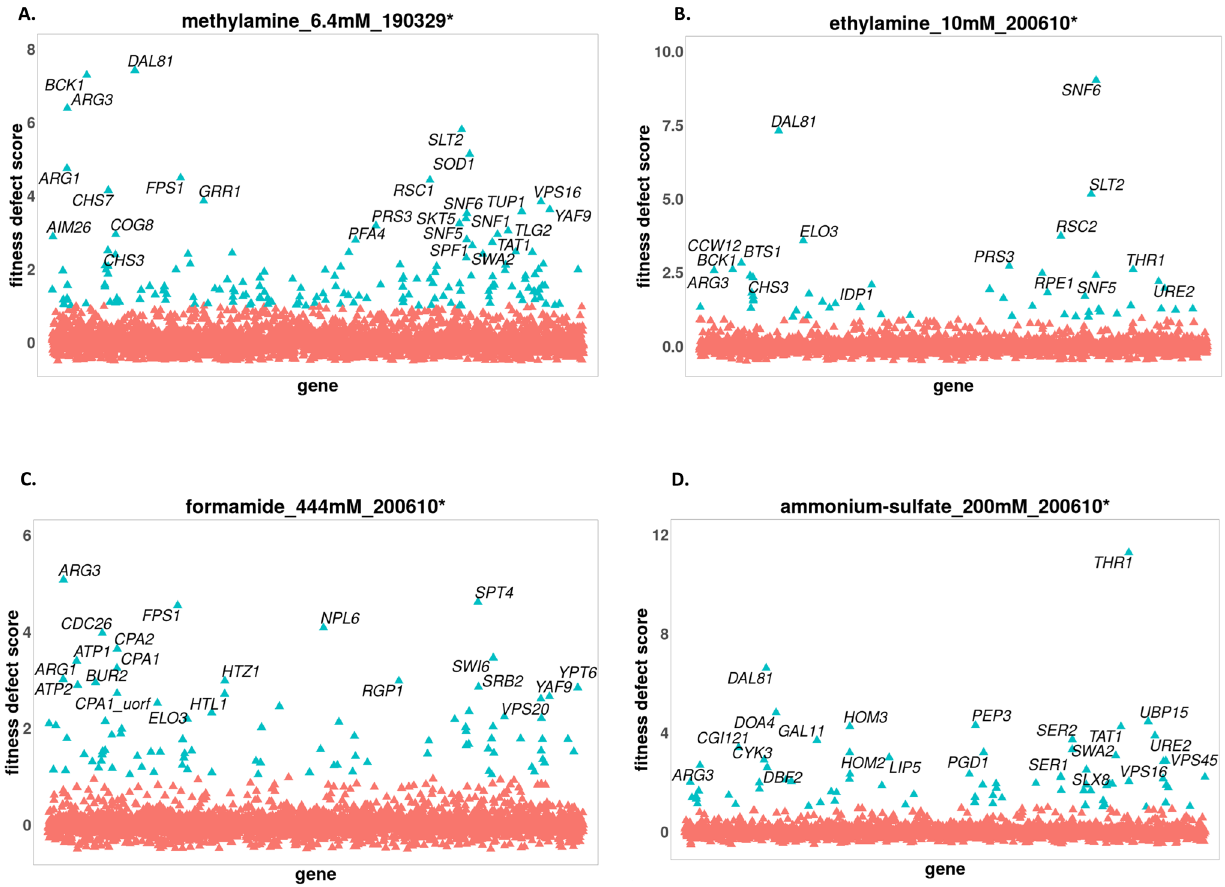
Figure 6. Fitness profile showing genes whose deletion strains are sensitive to treatment by metabolic intermediates of nitrosamines. Fitness defect scores are plotted on the vertical axis vs genes on the horizontal axis. Strains affected by the compounds lack the following genes; methylamine: BCK1 , DAL81 , ARG3 , FPS1 and GRR1 . Ethylamine: DAL81 , ARG3 , SNF6 , ELO3 , SNF6 and ELO3 . Formamide: ARG3 , FPS1 , NPL6 and SPT4 . Ammonium sulfate: DAL81 , ARG3 , PEP3 , THR1 , etc. It could be seen that ARG3 was affected by all the metabolites, in addition to ARG1 being affected by methylamine and formamide. Concentration and date of count matrices analysis are indicated. Not all strains with significant FD scores are labelled. Plots were generated using the Bioconductor v3.12, https:// www. bioco nduct or.